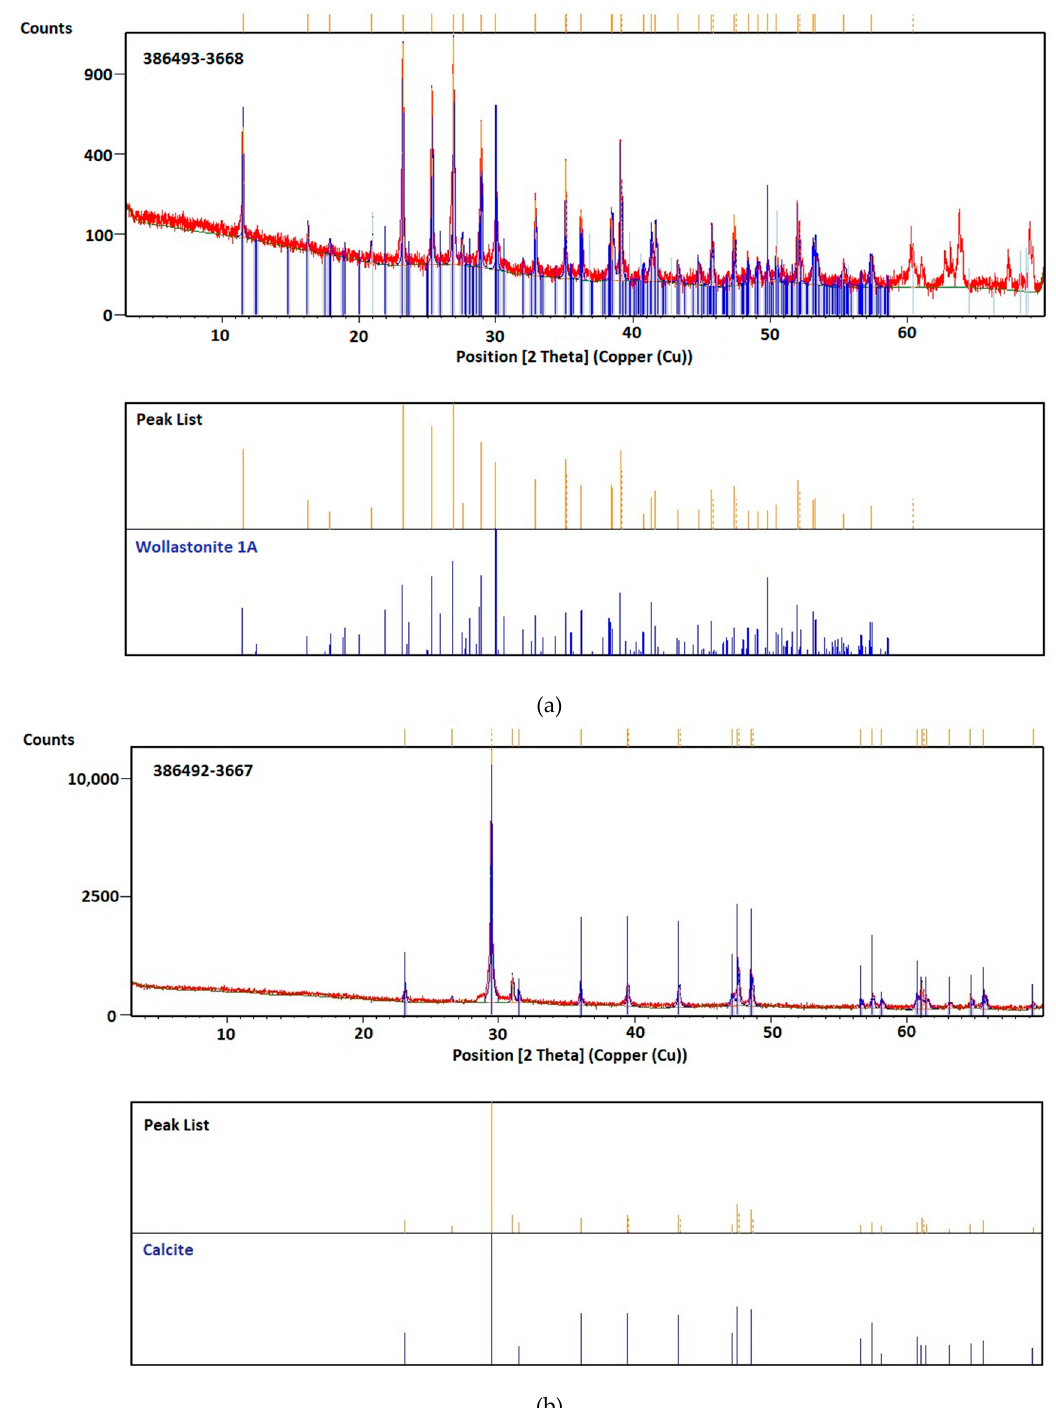
Figure 3. XRD analyses of wollastonite (a) and calcite (b) samples.